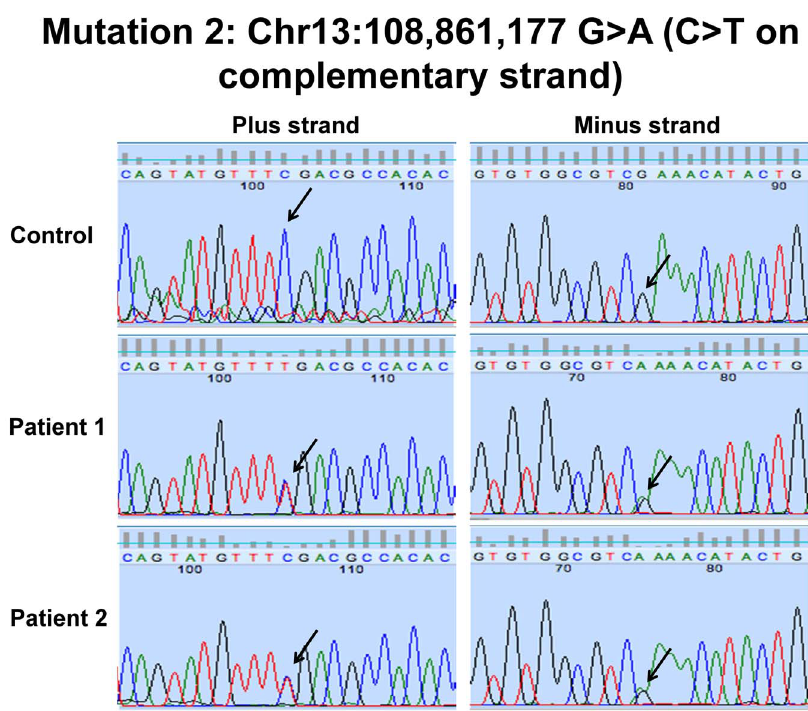
Figure 11. Sanger sequencing of LIG4 c.2440C . T variant in Patients 1 and 2.